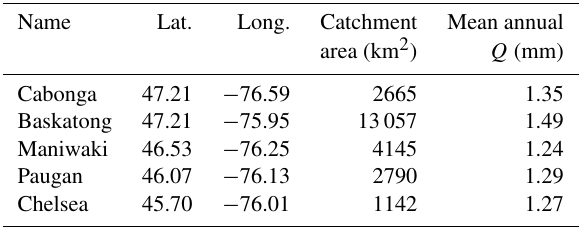
Figure 2. Hydrograph of the daily streamflow (millimeters per day; hereafter mmd − 1 ) averaged over each month during 33 years from 1985 to 2017. Table 1. Hydroclimatic characteristics of five sub-catchments of the Gatineau